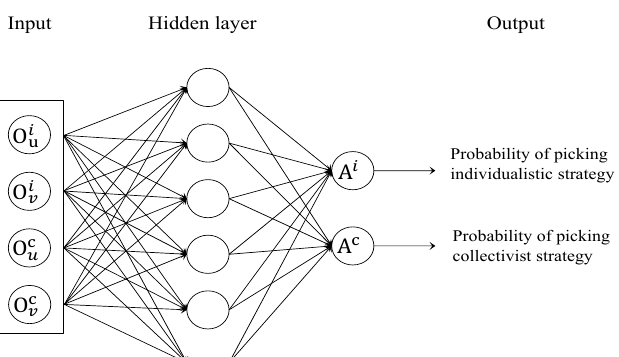
Figure 4. Our neural network with two fully connected layers. Four possible state observations are used as input and we set up 10 neurons in the hidden layer. In the hidden layer, we use the tanh activation function to achieve the conversion from the linear model to the nonlinear model, and initialize the weights randomly. Then, the probabilities of picking individualistic strategy and collectivist strategy are set as the